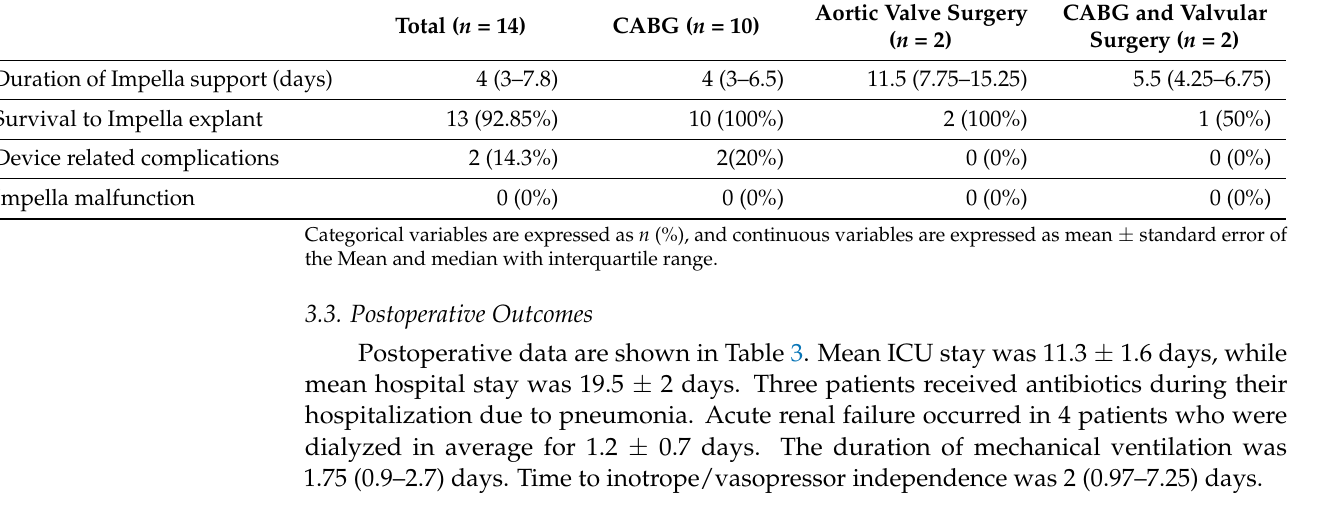
Table 3. Postoperative patient